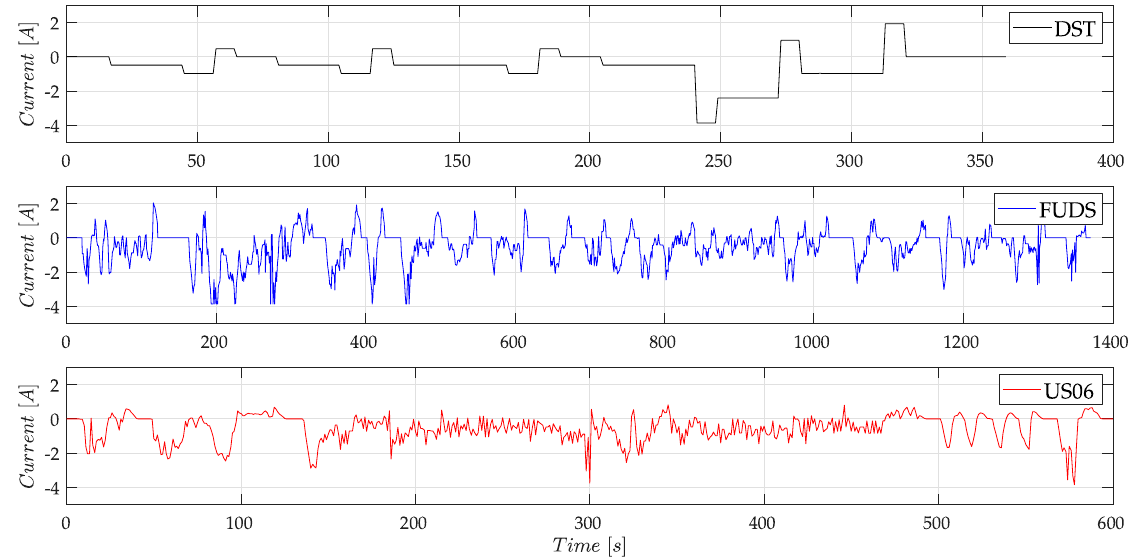
Figure 11. Dynamic test profile showing the applied current for A123 dataset: Dynamic Stress Test (DST), Federal Urban Driving Schedule (FUDS) and US06 Highway Driving Schedule